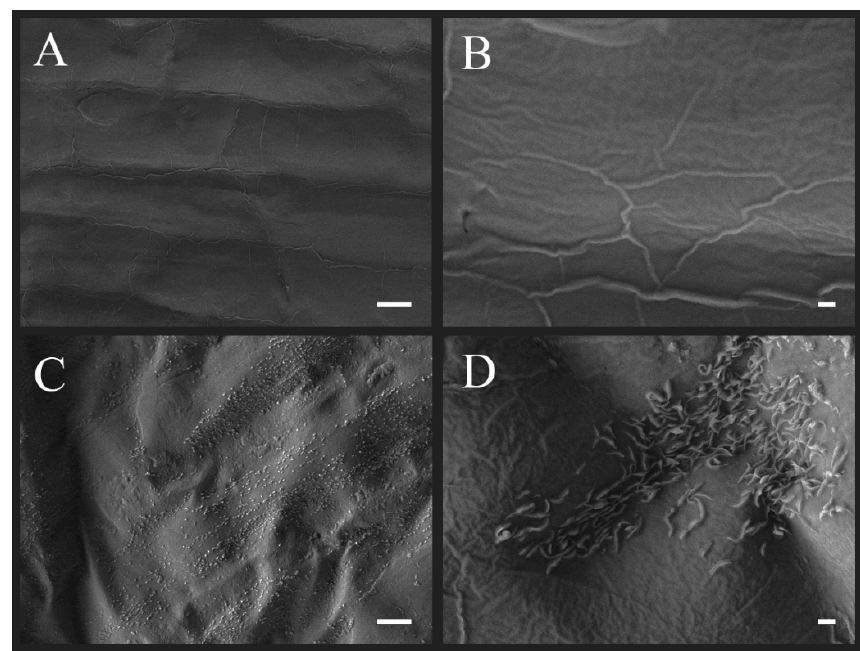
Figure 3. Scanning Electron Microscopy (SEM) images of garlic clove surface. ( A , B ): untreated control; ( C , D ): plasma treatment at 30 Pa. ( A , C) : 1000 × magnification, scale bar = 10 µm; and, ( B , D ): 5000 × magnification, scale bar = 1 µm.